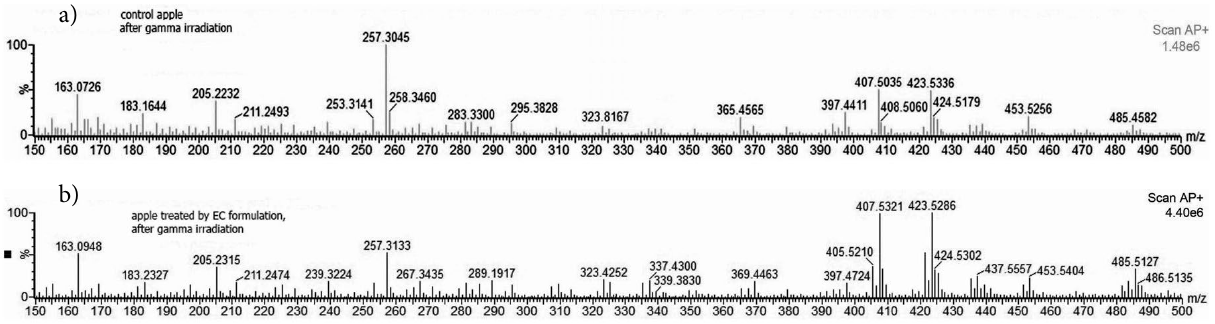
Figure 3 . ASAP-MS spectra of a control apple after gamma irradiation ( a ) and of an apple treated with 50 mg/L EC formulation and with H 2 O 2 and then gamma irradiated ( b